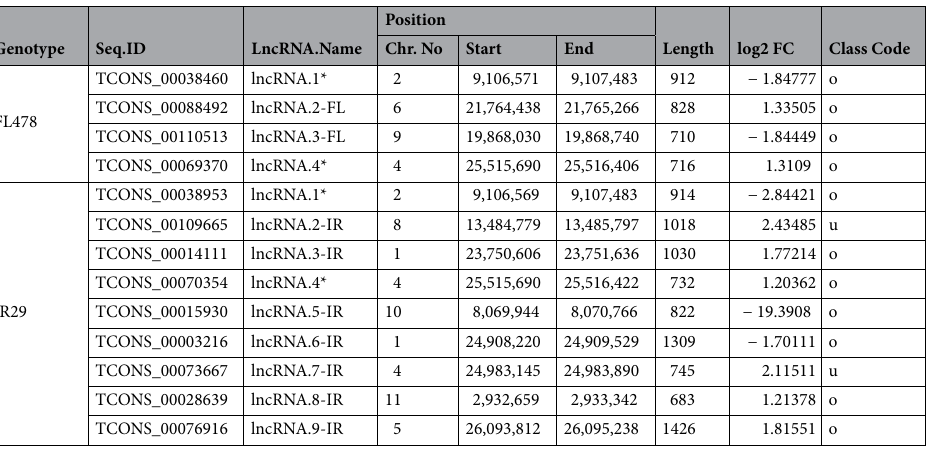
Table 1. Details of the identified DE-lncRNA in FL478 and IR29 genotypes (the asterisk represents coincided DE-lncRNAs in both genotypes).